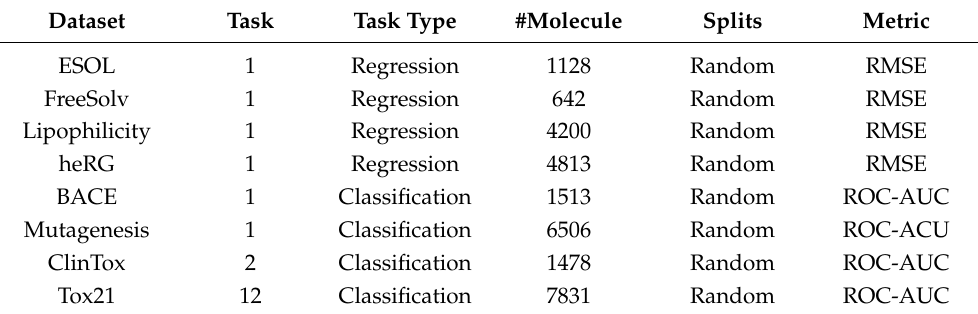
Table 2. The details of the